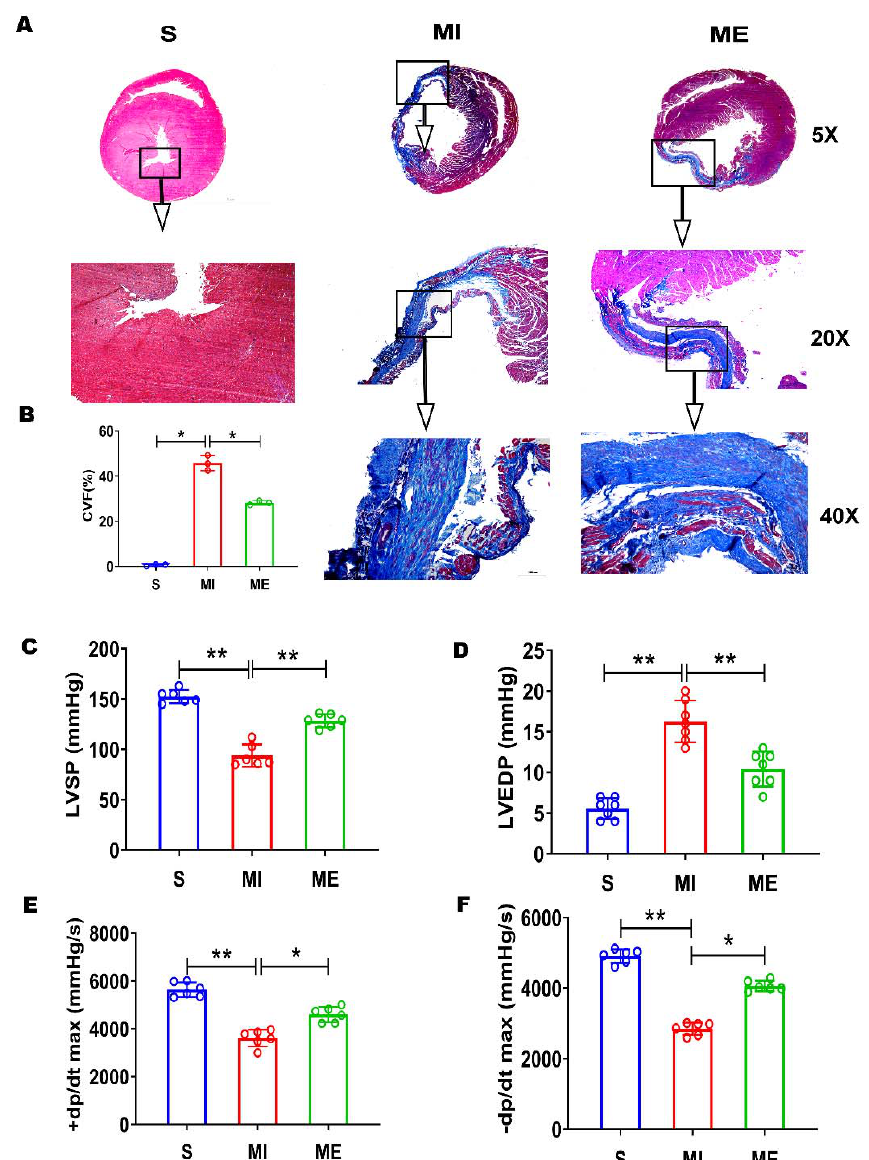
Figure 2. Post-myocardial infarction (MI) aerobic exercise training alleviates myocardial pro-fibrotic remodeling and improves left ventricular (LV) function in the rat heart. ( A ) Representative pictures of Masson staining of paraffin sections in the rat heart (in 5 × , 20 × , 40 × microscopic magnification, respectively), which show that normal myocardial fibers are stained in red, whereas collagen fibers are stained in blue color. ( B ) Bar graph shows quantified myocardial collagen volume (CVF%, n = 3/group), which equals Blue area/(Blue area + Red area) × 100. ( C – F ) Bar graphs show averaged systolic (LVSP, +dp/dtmax) and diastolic (LVEDP, − dp/dtmax) LV function parameters ( n = 6/group). Abbreviations: S, sham control group; MI, myocardial infarction group; ME, post-MI exercise trained group. Symbol * indicates p < 0.05 and ** indicates p < 0.01 between the relevant groups that are